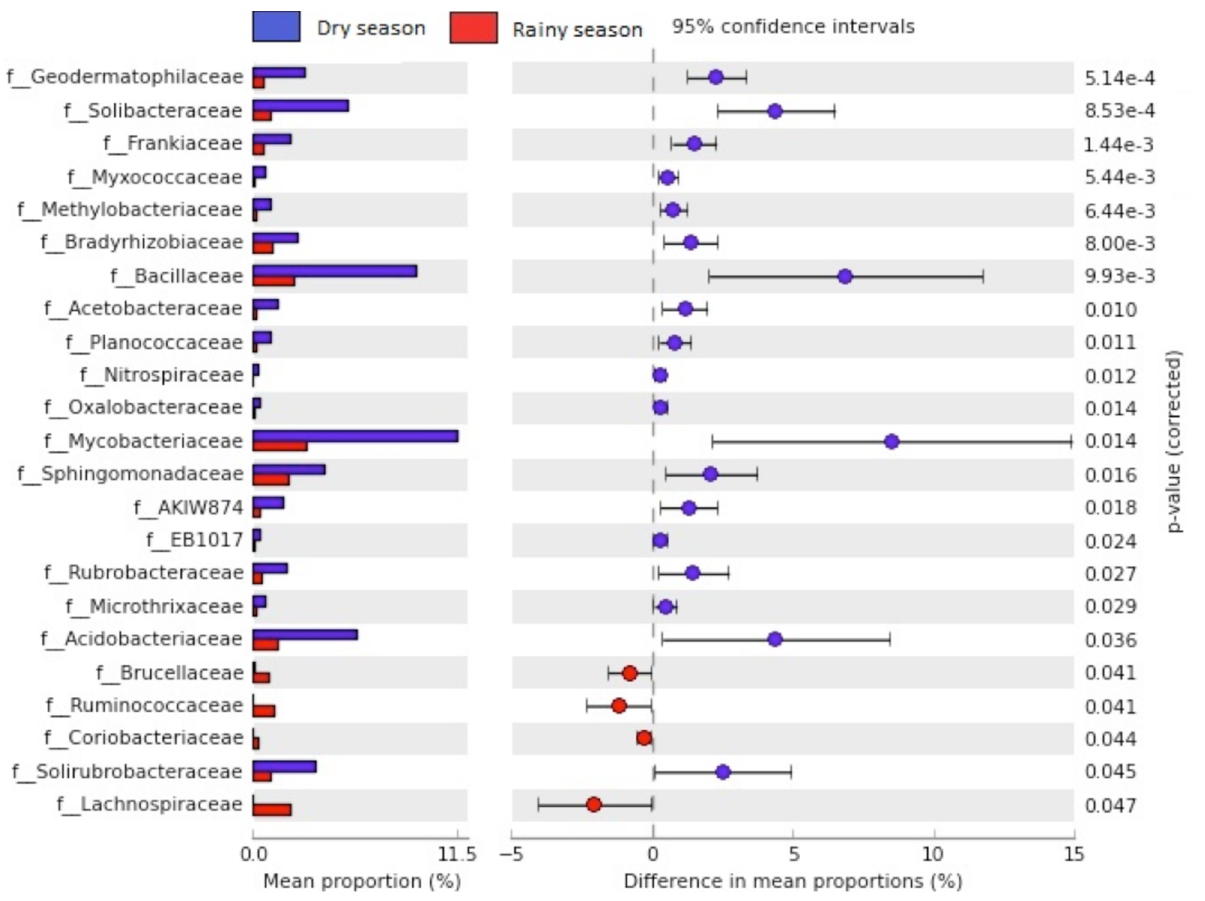
Figure 7. The twenty-three most significant families (p , 0.05) with respect to the season.